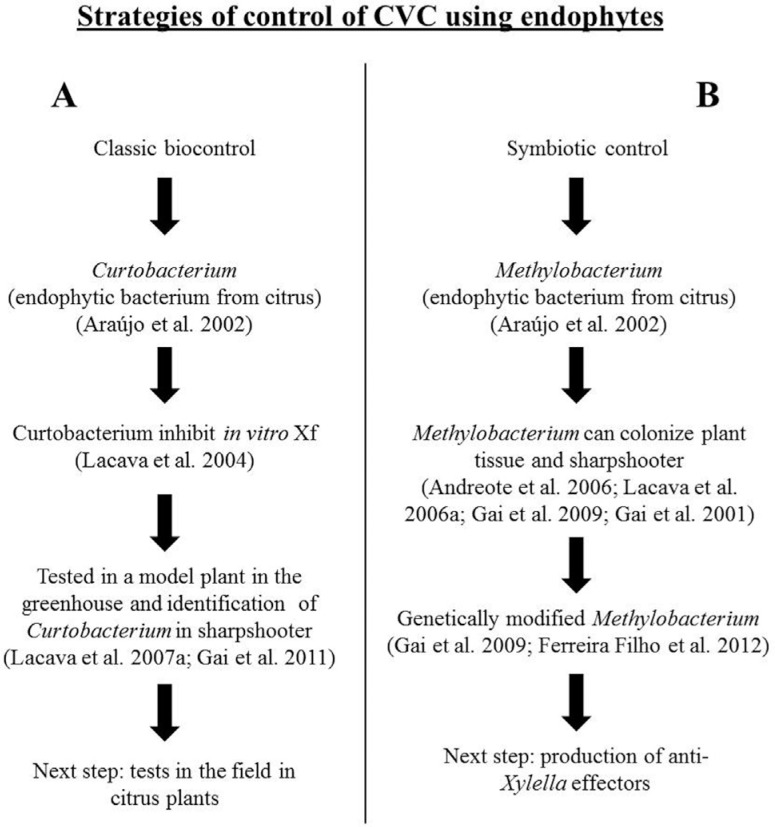
Hypotheses and strategies to control citrus variegated chlorosis (CVC) using
endophytic bacteria from citrus plants. (A) We suggest the endophytic bacterium
Curtobacterium flaccumfaciens as a classical biological
control agent. C. flaccumfaciens has the ability to colonize
plant tissues in the presence or absence of Xylella fastidiosa
(Xf). This is a prerequisite for the use of this bacterium as a biocontrol agent.
The data indicate that C. flaccumfaciens interacted with
X. fastidiosa in Catharanthus roseus and
reduced the severity of the disease symptoms induced by X.
fastidiosa (Araújo et
al., 2002; Lacava et
al., 2004; Lacava et
al., 2007a; Gai et
al., 2011). (B) Additionally, the endophytic bacterium
Methylobacterium has been suggested as a qualified candidate
for a paratransgenic symbiotic control (SC) strategy because there have been
reports on the transmission, colonization and genetic manipulation of
Methylobacterium, which are prerequisites for the potential
use of this bacteria to interrupt transmission of X. fastidiosa,
the bacterial pathogen causing CVC, by insect vectors (Araújo et al., 2002; Andreote et al., 2006; Lacava et al., 2006a; Gai et al. 2009, 2011; Ferreira Filho
et al., 2012).